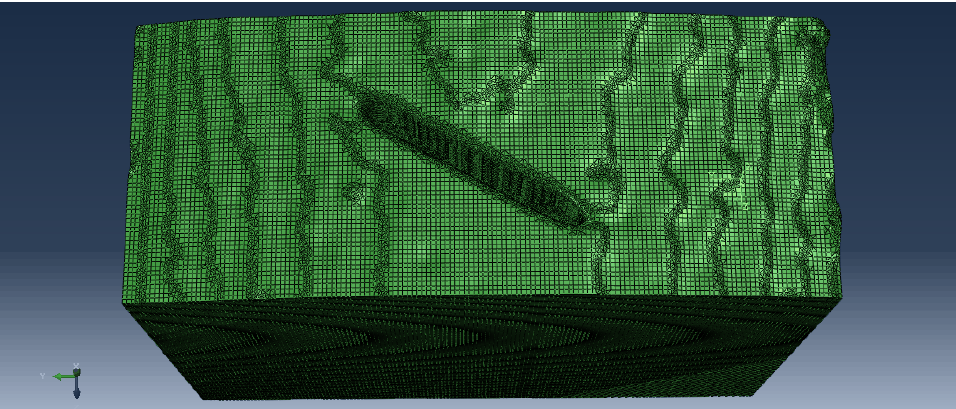
Figure 4: FEM mesh of the actual notch